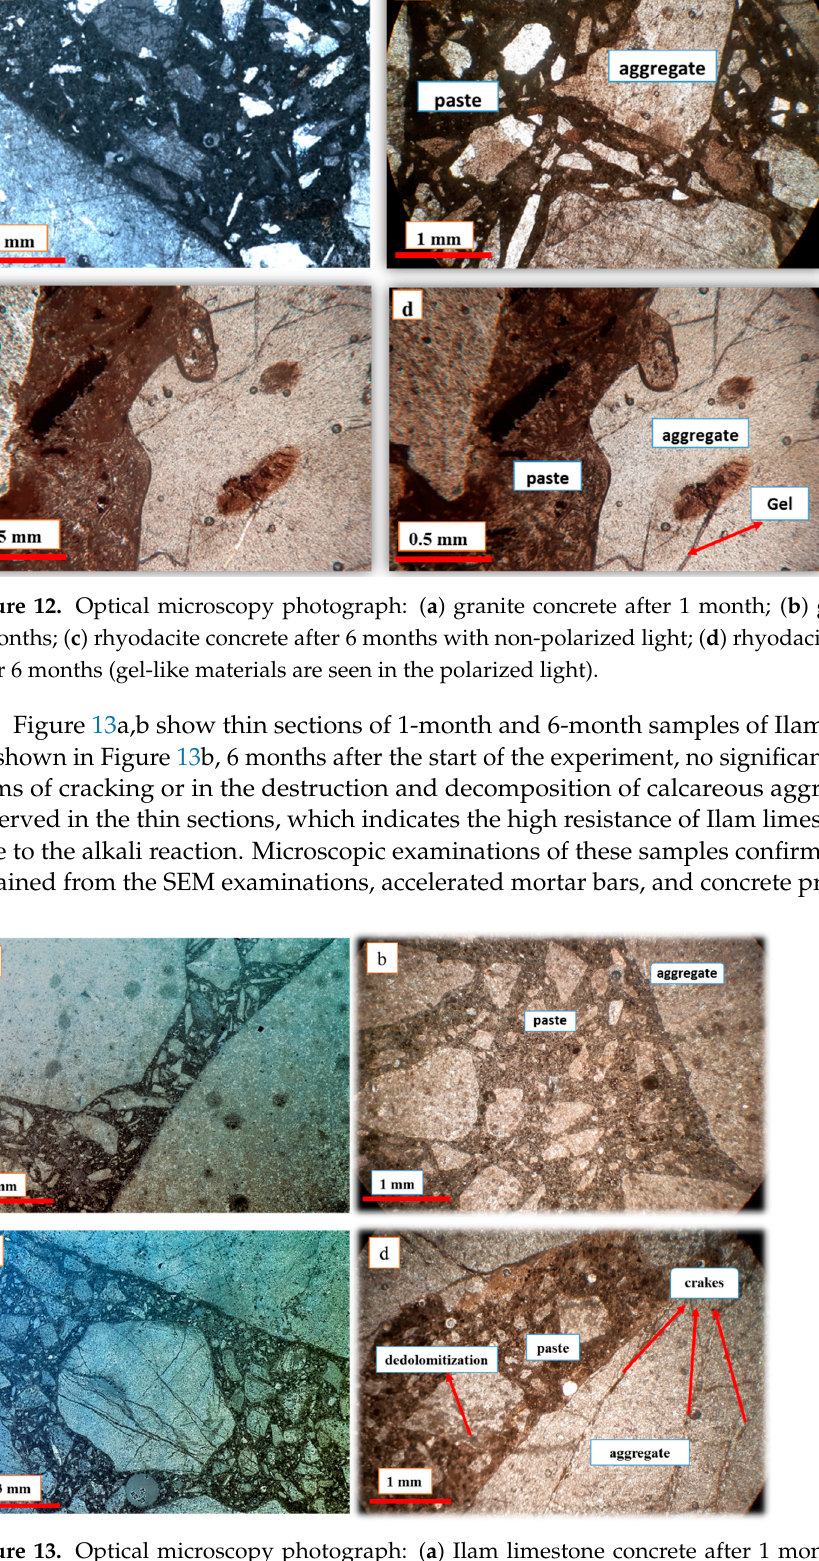
Figure 13. Optical microscopy photograph: ( a ) Ilam limestone concrete after 1 month; ( b ) Ilam limestone after 6 months; ( c ) dolomite concrete after 1 month; ( d ) dolomite aggregate after 6 months (aggregate cracking and dedolomitization are seen in the